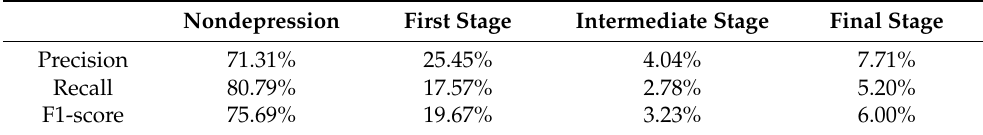
Table 12. Classification performance for the four-class classification in Setting 2.